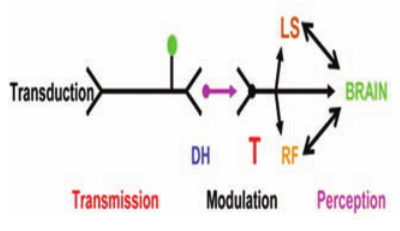
Figure 7. Ballas figure on molecular mech- anisms of pain.